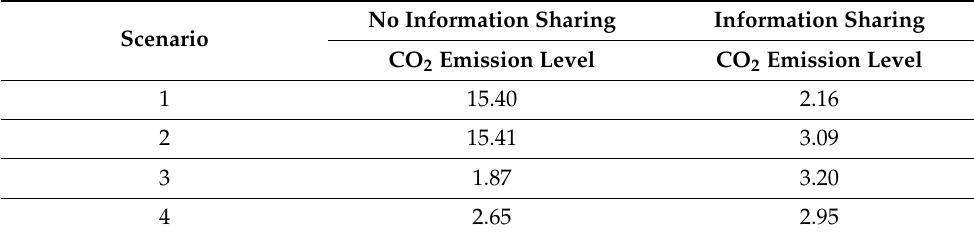
Table 7. MAPE by main model scenarios and CO 2 emission level of actual and